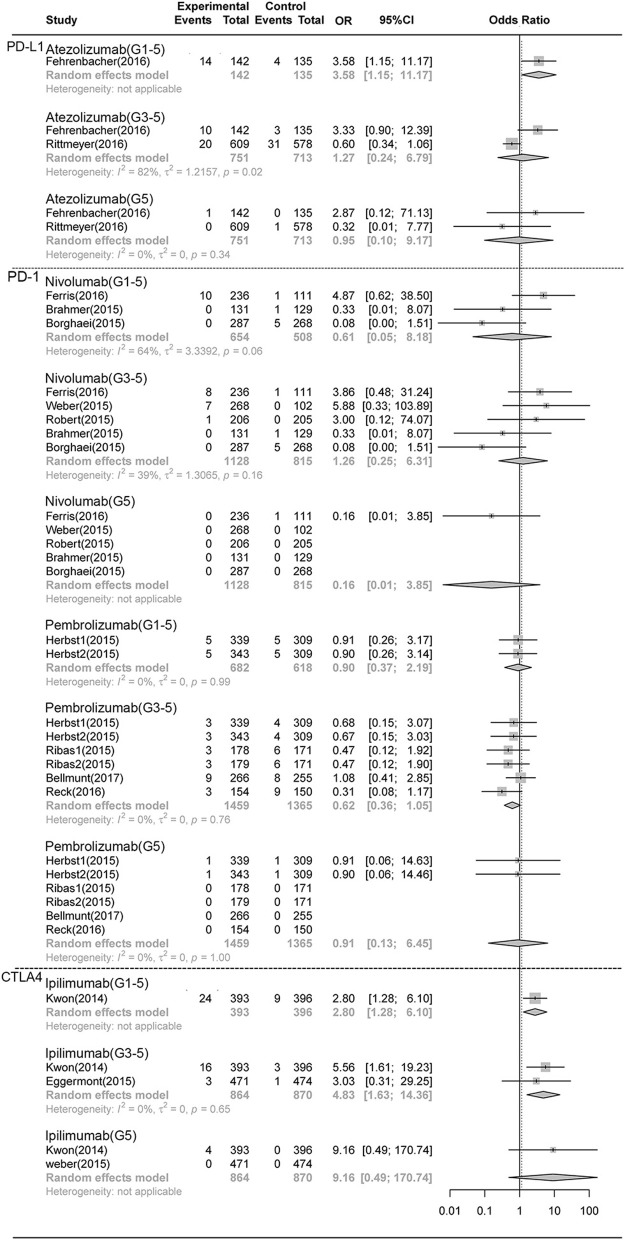
Forest plot analysis of pneumonia comparing different ICIs with control therapies. Atezolizumab, atezolizumab V.S. chemotherapy; Nivolumab, nivolumab V.S. chemotherapy; Pembrolizumab, pembrolizumab V.S. chemotherapy; G1-5, grade 1-5; G3-5, grade 3-5, G5, death.